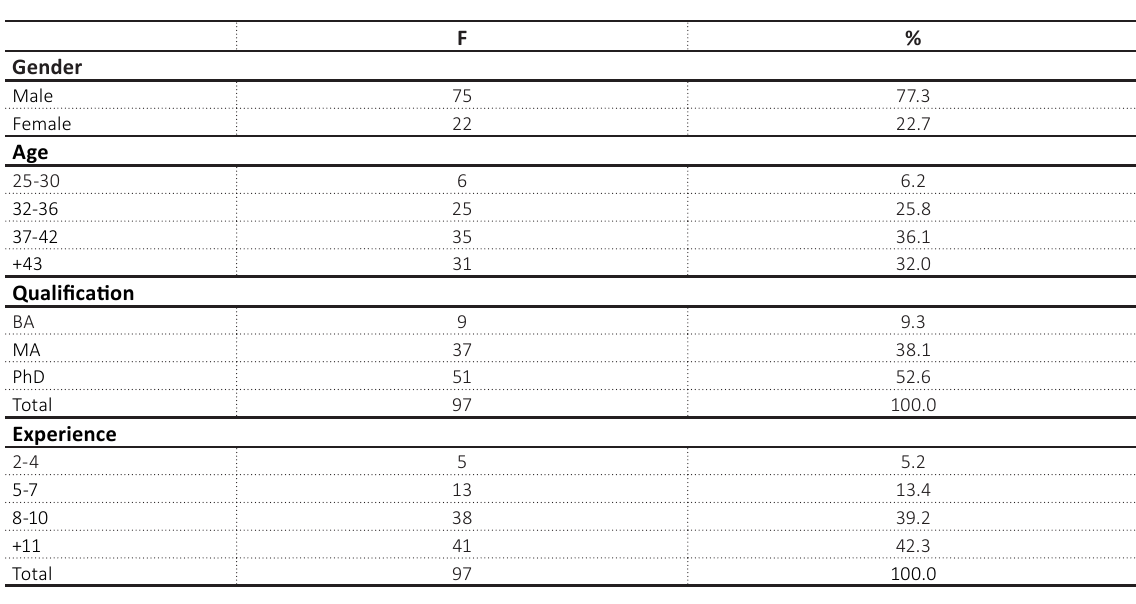
Table 1. Study sample